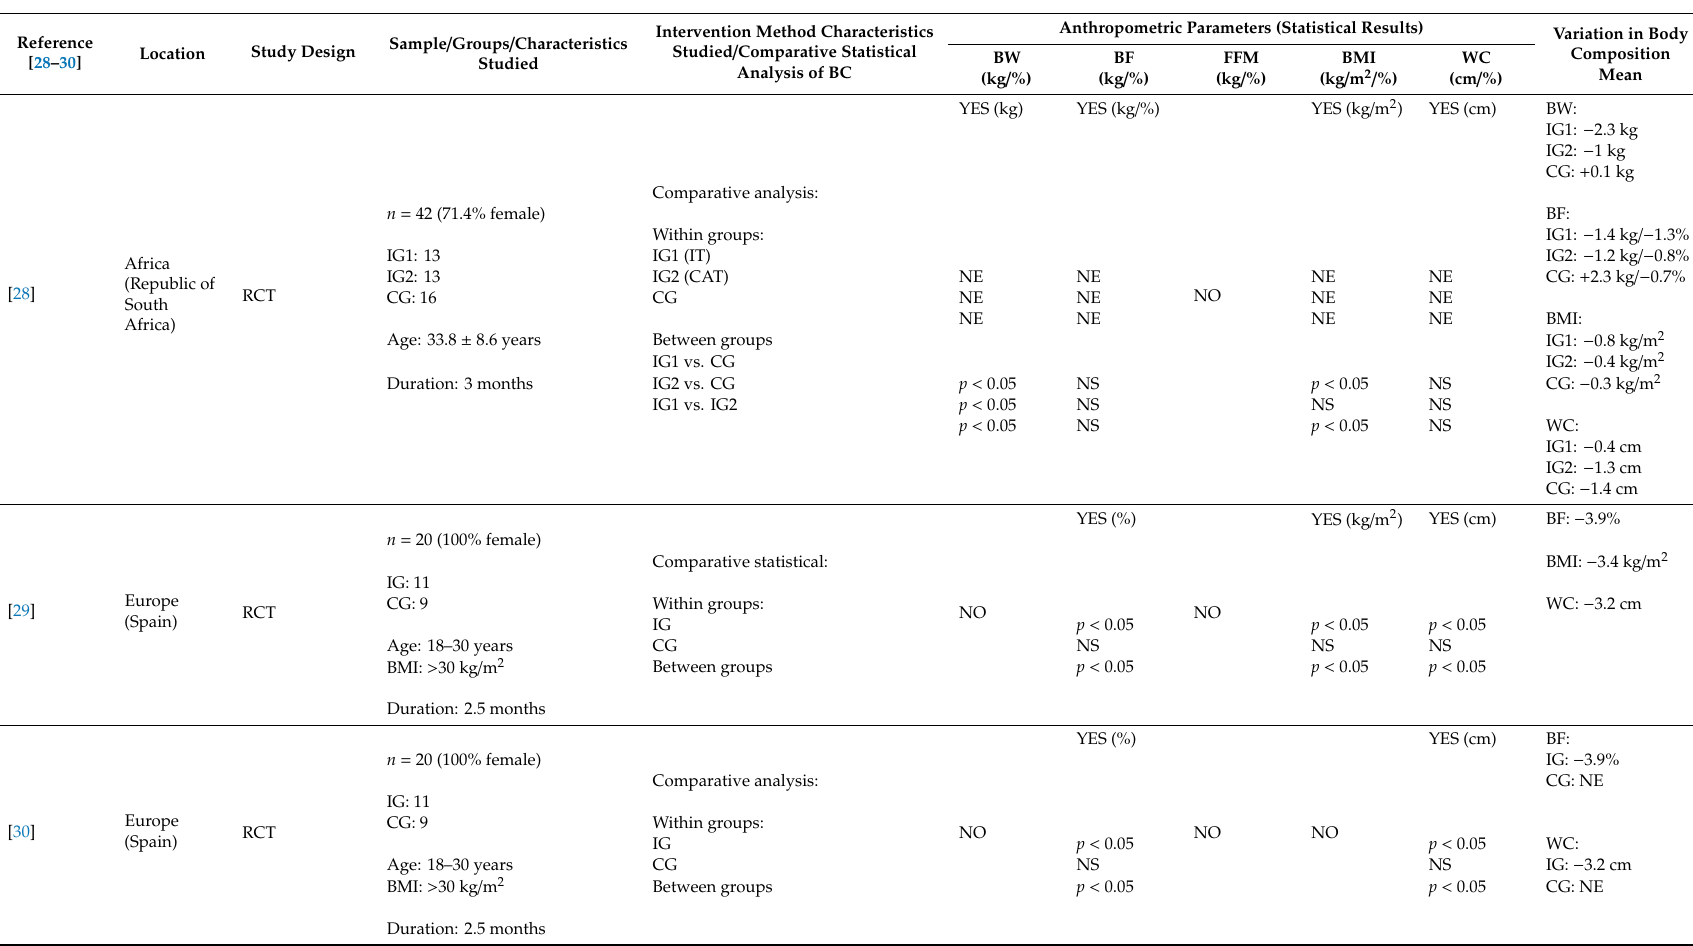
Table 3. Clinical trials including adults su ff ering DS in which the variation of body composition was analyzed (intervention in physical exercise). Reference